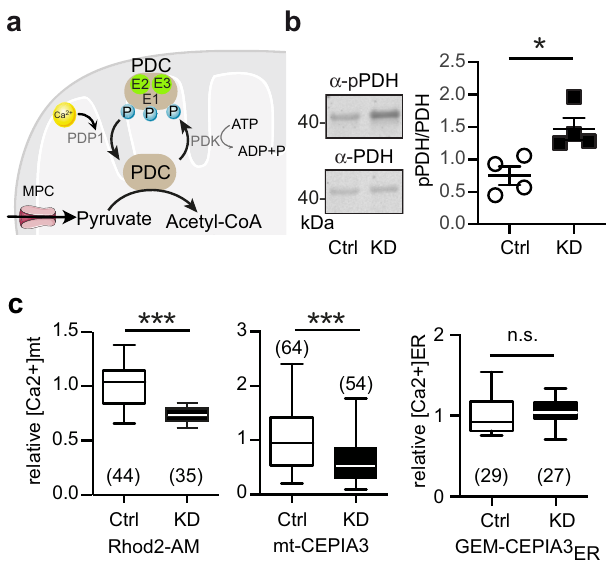
Fig. 3 Hyperphosphorylated pyruvate dehydrogenase and reduced mitochondrial Ca 2 + levels in GDAP1 KD cells. a Scheme showing the regulation of the pyruvate dehydrogenase complex (PDC). The PDC E1 subunit can be phosphorylated by the catalytic activity of the PDH kinase (PDK). The PDH phosphatase subunit 1 (PDP1) in turn dephosphorylates the serine residues upon activation by Ca 2 + . MPC, mitochondrial pyruvate carrier;PDK1, pyruvate dehydrogenase kinase 1. b Immunoblots from whole cell lysates for quanti fi cation of PDH E1 phosphorylation (serine 293), normalized to total PDH E1 levels revealed increased phosphorylation of PDH in GDAP1 KD cells. c Mitochondrial Ca 2 + measured with the fl uorescent dye Rhod2-AM or mito-CEPIA normalized to mito-FarRed indicated reduced mt[Ca 2 + ] levels. ER[Ca 2 + ] levels measured with the genetically encoded Ca 2 + sensor GEM-CEPIA3 ER did not show any variation between the cell lines. Data in ( c ) were from 3 independent experiments with the indicated number of cells. Data for GEM-CEPIA3 ER were from 2 independent experiments. Statistical variation is shown as scatter plots in ( b ) and Tukey boxplots in ( c ). Signi fi cance was calculated using the non-parametric Mann – Whitney in ( b ) and Student ’ s t test in ( c